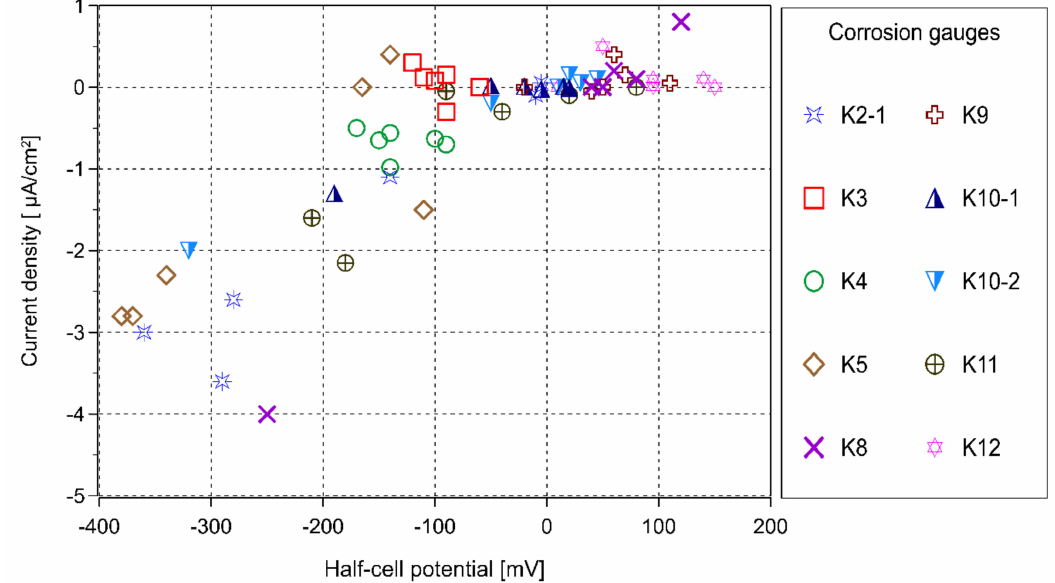
Figure 3. Results of corrosion monitoring after 17 years of exposure to the maritime